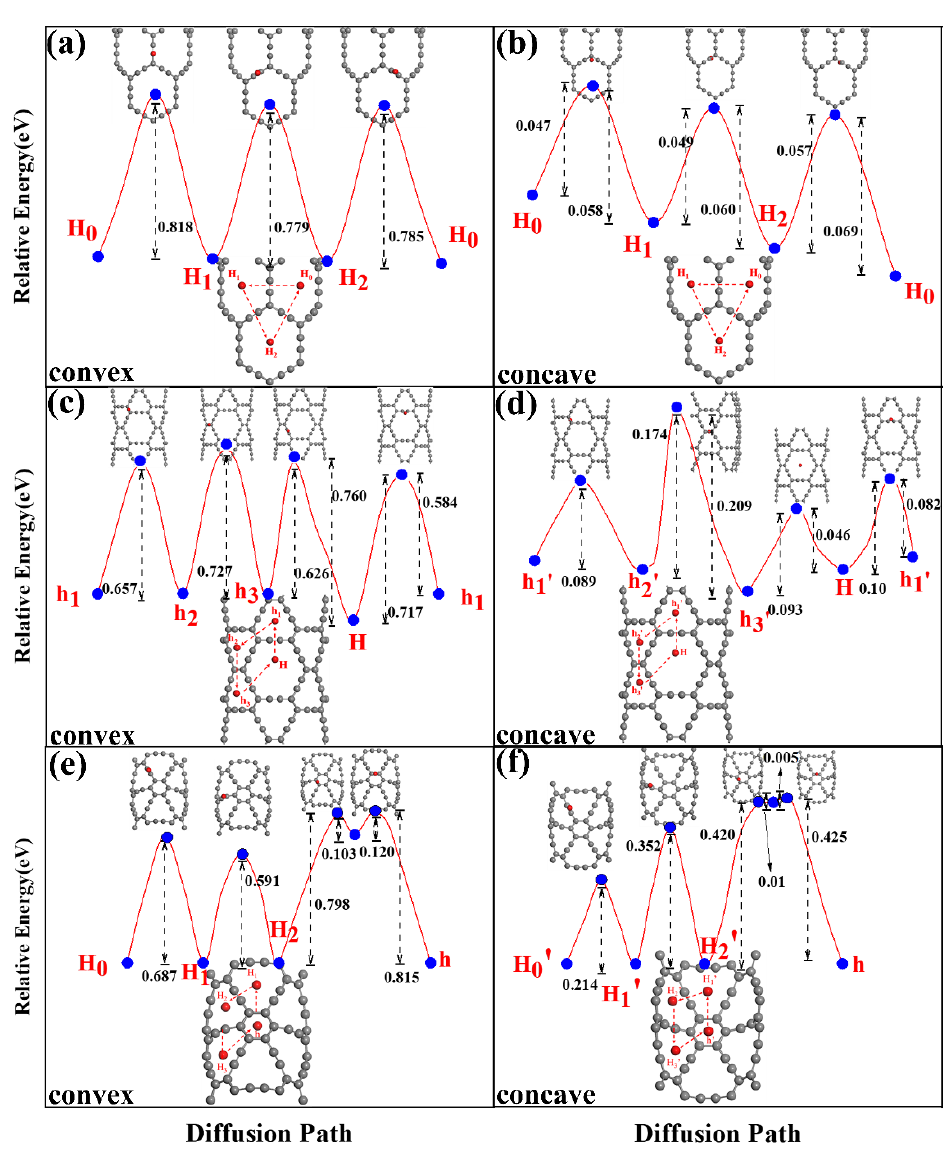
Figure 7. Schematics of the diffusion path and energy profiles for a sodium-ion on ( a , b ) (3, 0)- α GyNT, ( c , d ) (2, 0)- β GyNT, and ( e , f ) (4, 0)- γGyNT .